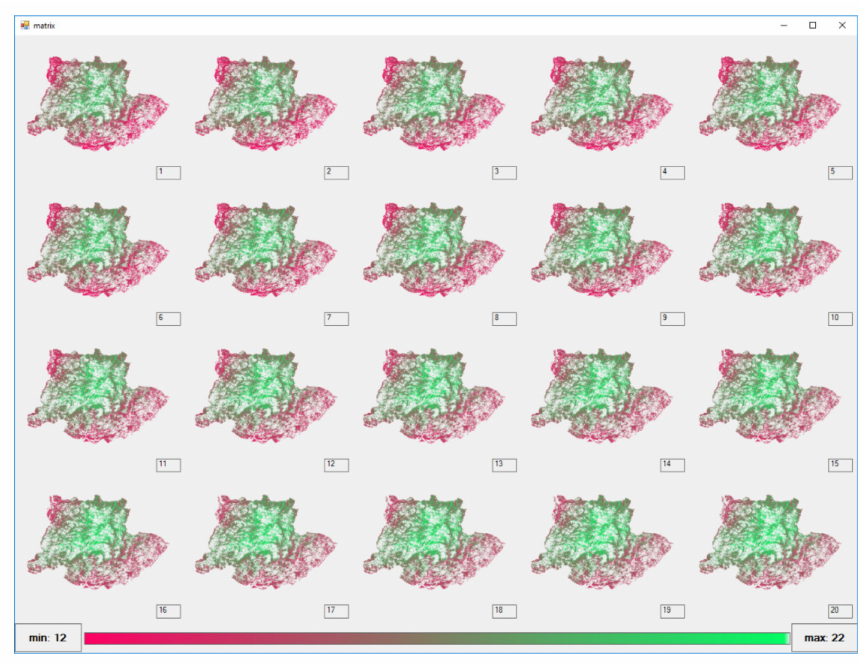
Figure A7. Price distribution for Scenario 1 (Biomass II (B 2 ), felling) over a period of 20 years (t 1 to t 20 ) in the Nordeste region, Portugal. The minimum price was 12 € / m 3 (light red) and the maximum 22 € / m 3 (light green).